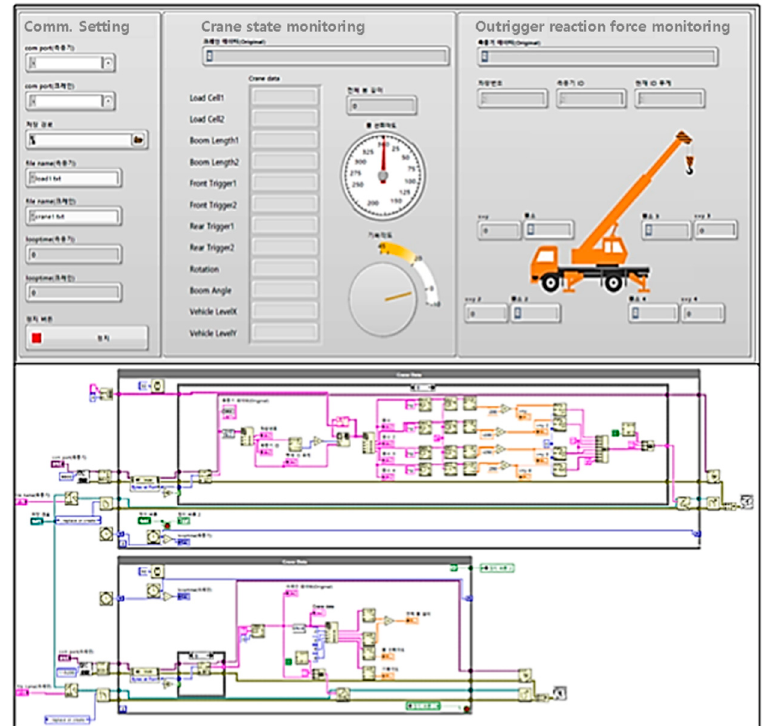
Figure 8. The real time monitoring system of mobile crane.